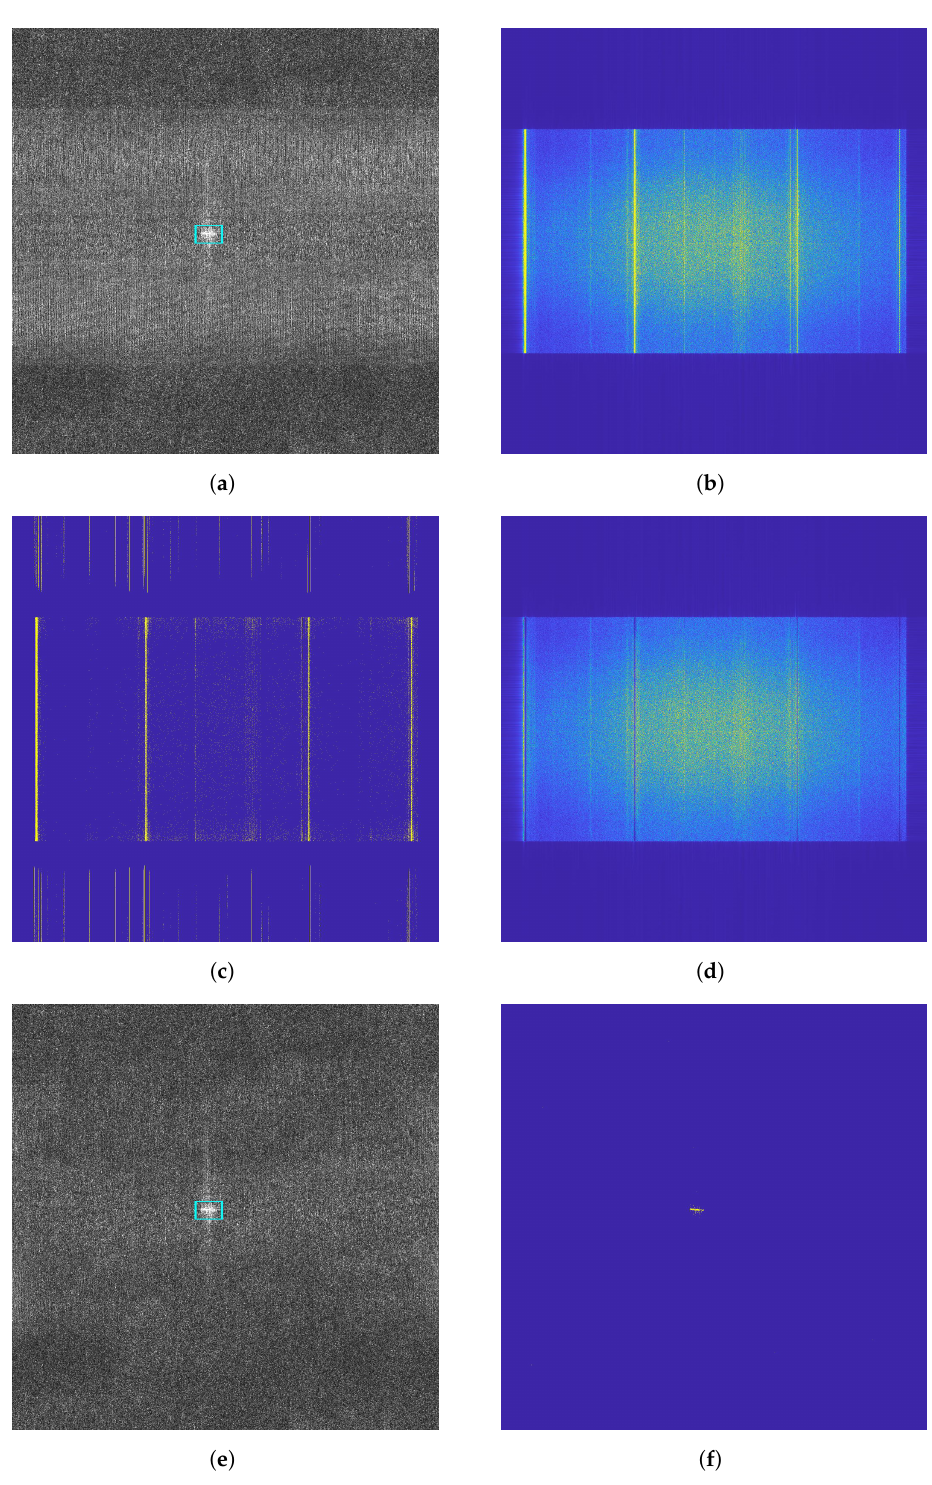
Figure 3. Images in the processed steps of the second experiment. ( a ) SAR image; ( b ) Image 2-D spectrum; ( c ) CFAR detection of RFI from the 2-D spectrum ( d ) Weighted 2-D spectrum; ( e ) Output clean image; ( f ) CFAR detection of ship from the clean